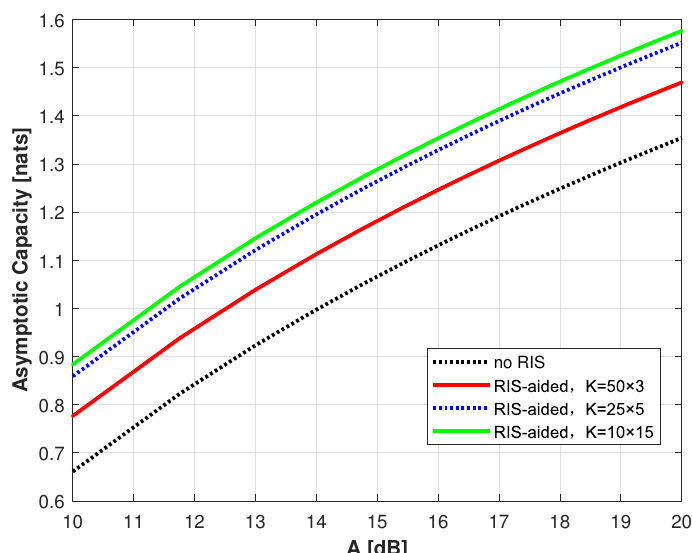
Figure 6. Asymptotic capacity versus deployment of